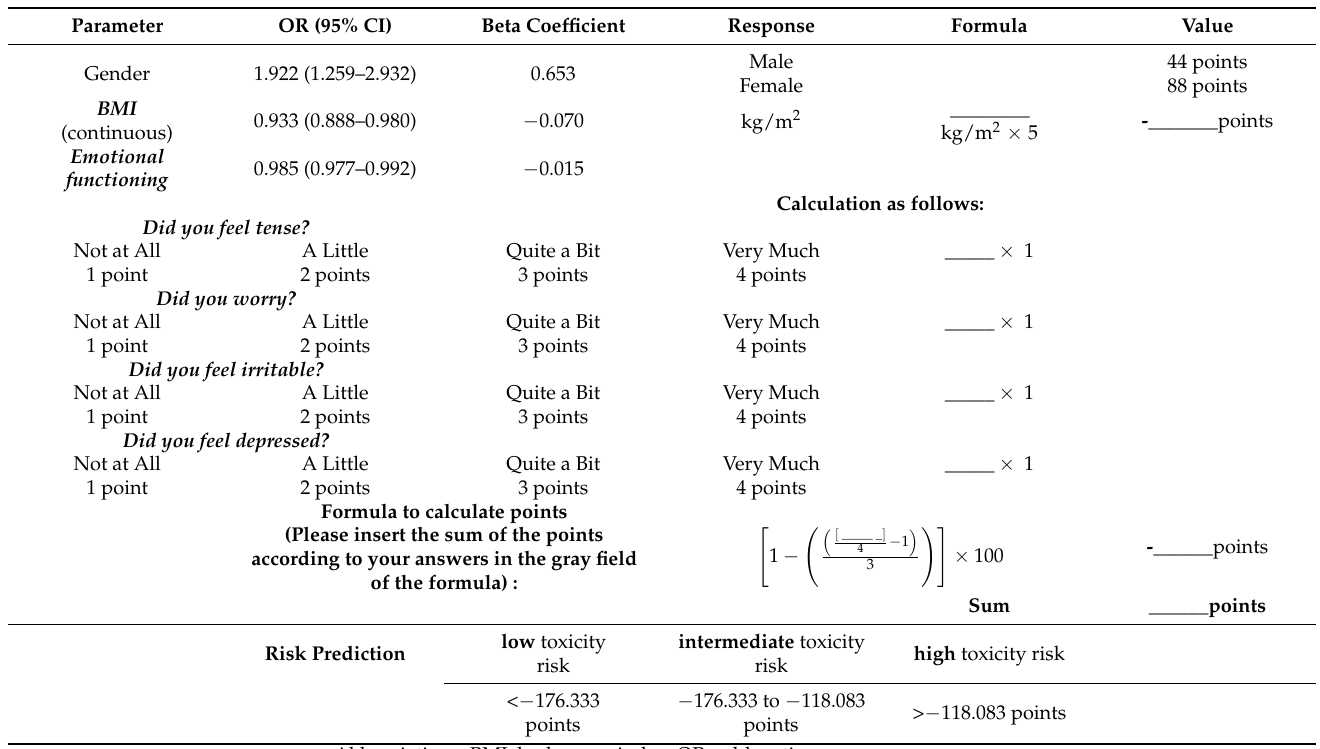
Table 2. Multivariable binary logistic regression predictive model and scoring algorithms for the toxicity risk